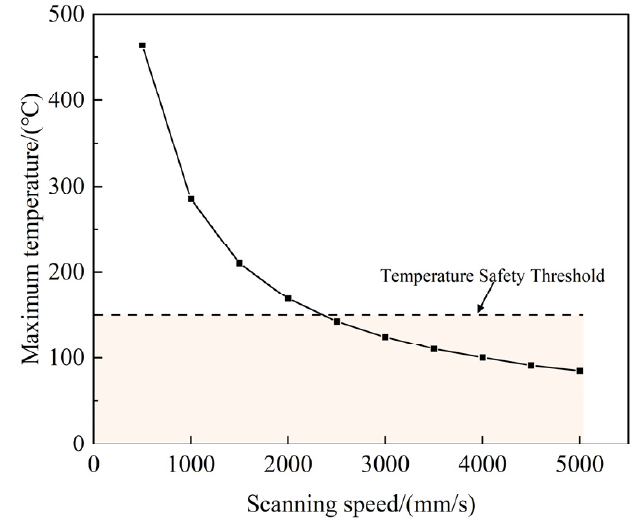
Figure 4. Maximum temperature change in the insulator surface at di ff erent scanning speeds.